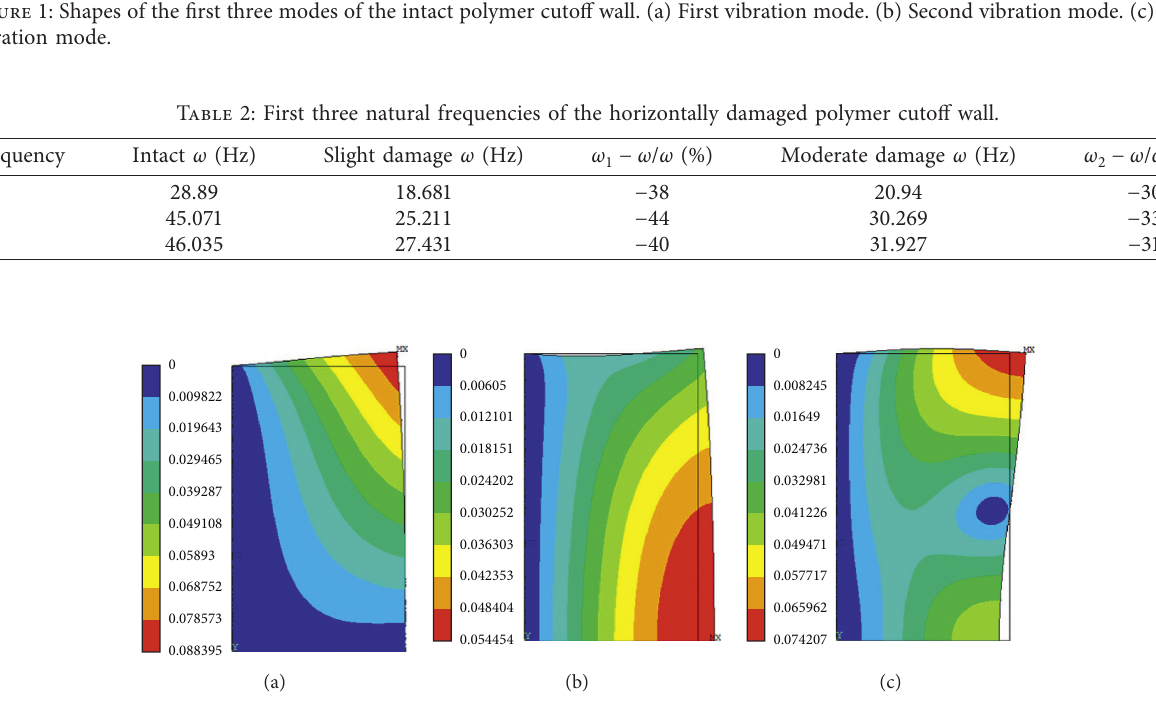
Figure 2: Shapes of the first three modes of the slightly horizontally damaged polymer cutoff wall. (a) First vibration mode. (b) Second vibration mode. (c) Third vibration mode.